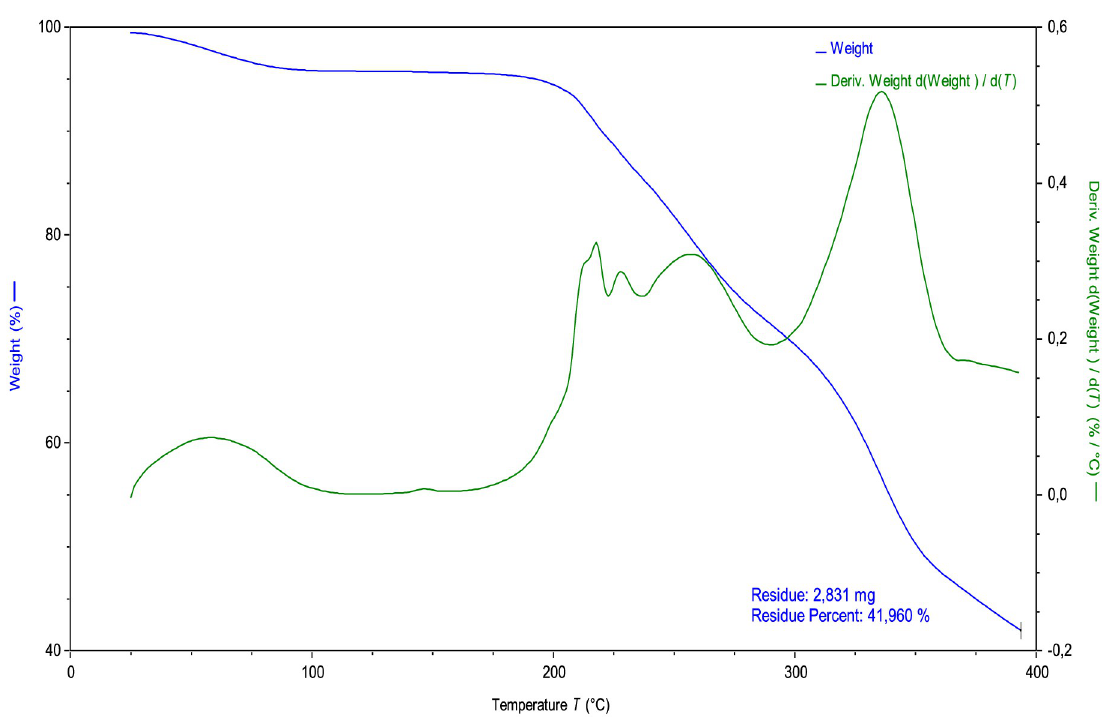
Fig 7. TGA rosuvastatin